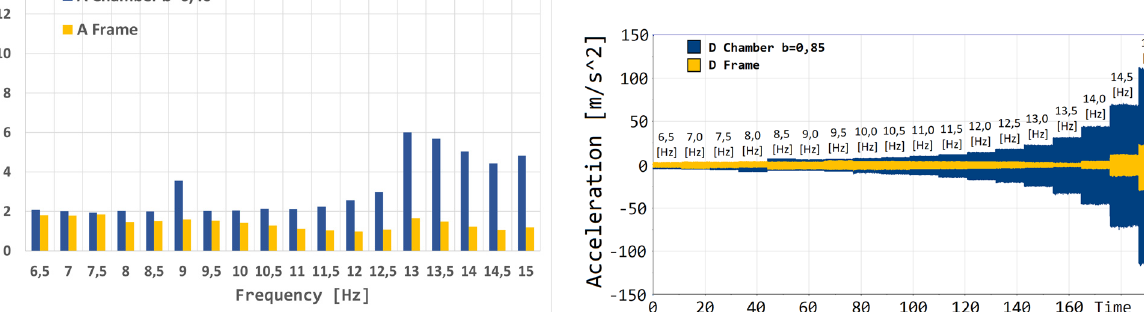
Figure 8: Quasi steady start up. Accelerations of the chamber and drive frame for the chamber fi lling degree equal to